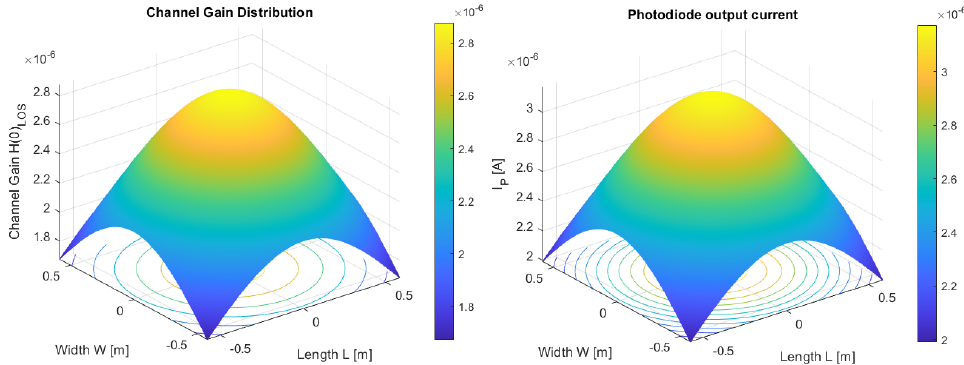
Figure 15. Channel gain in a LoS topology ( left ); Photodiode current distribution ( right ).